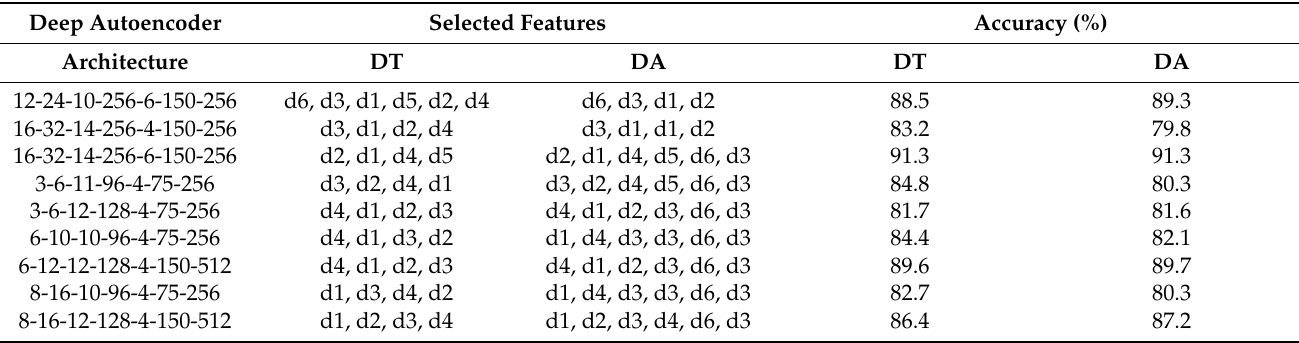
Table 2. Selected deep features in order of importance and corresponding classification accuracy for DT and DA classifiers.